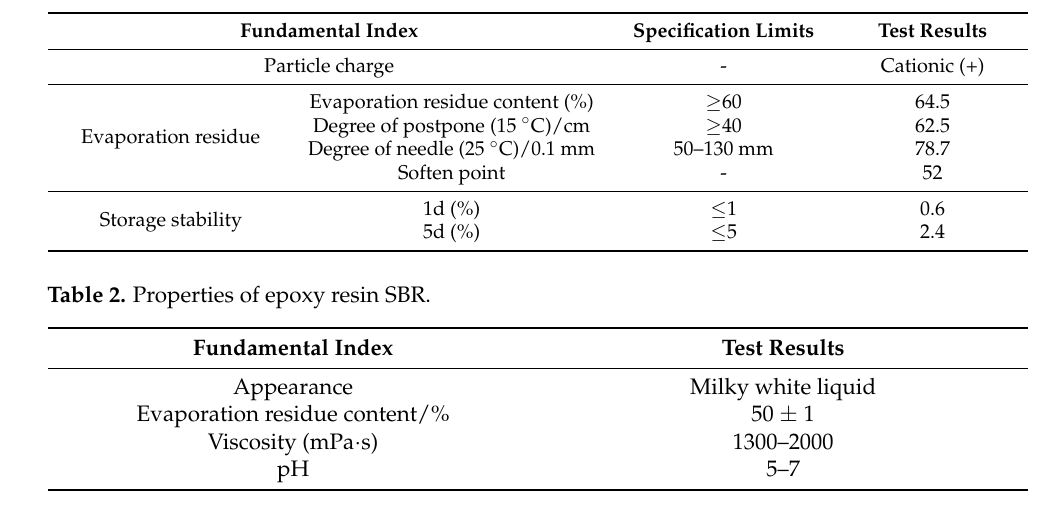
Table 1. Parameters of emulsified asphalt.